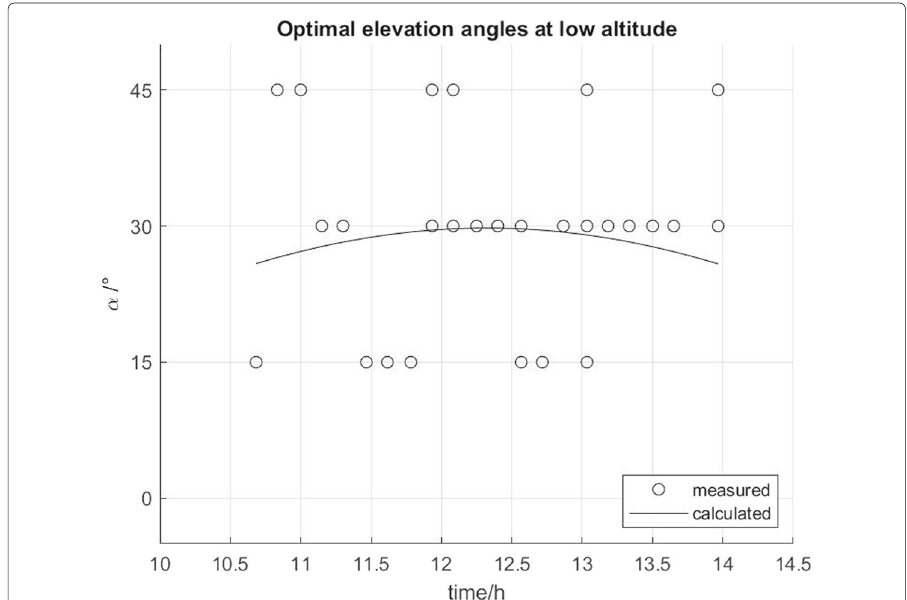
Fig. 13 Optimal elevation angles at low